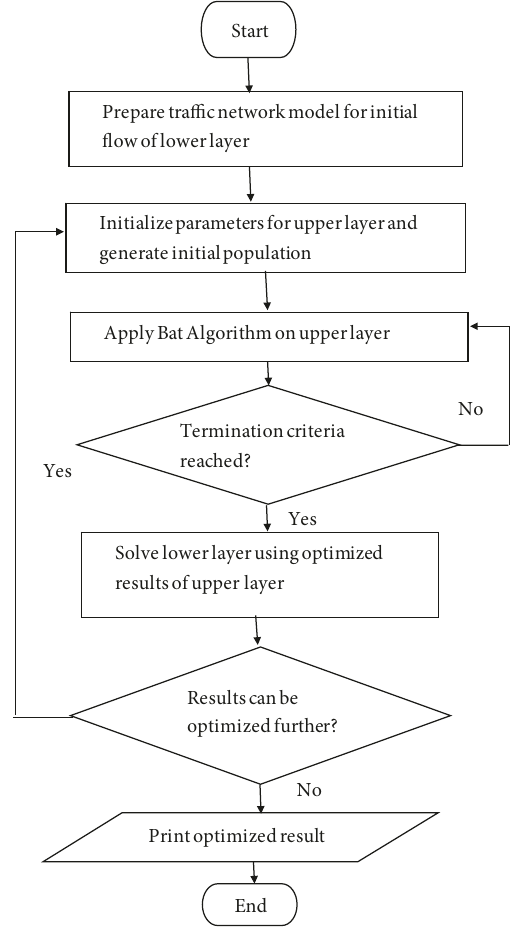
Figure 5: Flowchart for the traffic signal optimization problem using bat algorithm.